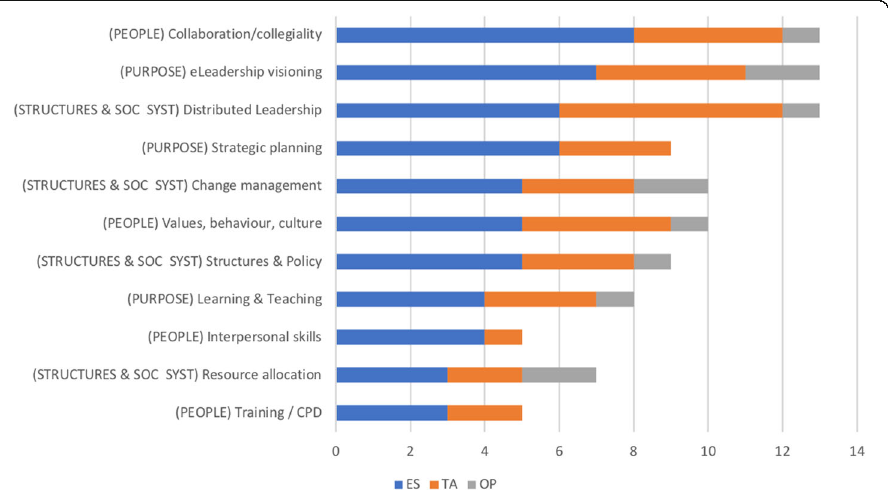
Fig. 6 Thematic analysis of results 2013-2017 compared to Jameson ’ s (2013) e-Leadership